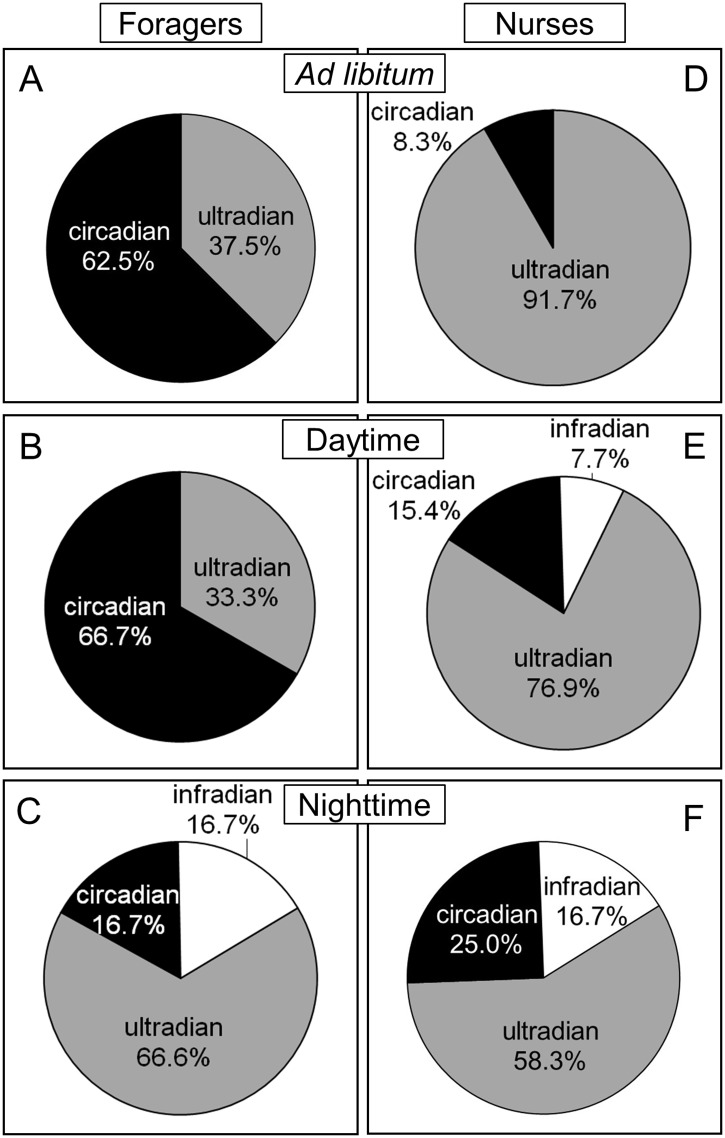
Percentage of foragers and nurses displaying either circadian, ultradian or infradian rhythms of caste-specific activities in the social context, under the three feeding regimes.Black: circadian rhythms (period lengths between 20 and 28h). Grey: ultradian rhythms (period lengths <20h). White: infradian rhythms (period lengths >28h) (A): foragers (n = 8) under ad libitum feeding; (B): foragers (n = 12) under daytime feeding; (C): foragers (n = 12) under nighttime feeding; (D): nurses (n = 13) under ad libitum feeding; (E): nurses (n = 12) under daytime feeding; (F): nurses (n = 12) under nighttime feeding.